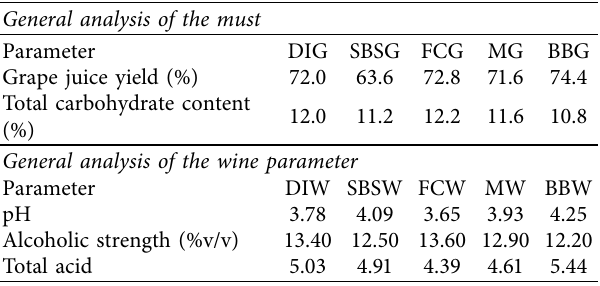
Table 1: General analysis of the must and wine parameter. General analysis of the